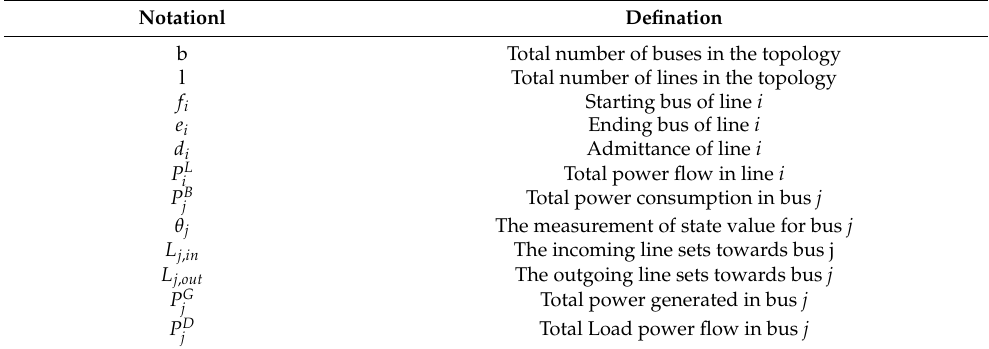
Table 2. Parameters for formal